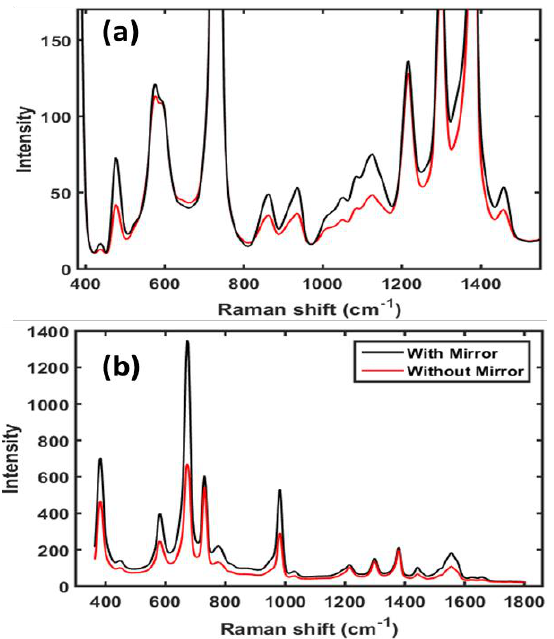
Figure 5. Preprocessed mean Raman spectra of central hundred pixels from S1 ( a ) and from S2 ( b ) collected with and without reflection mirror.